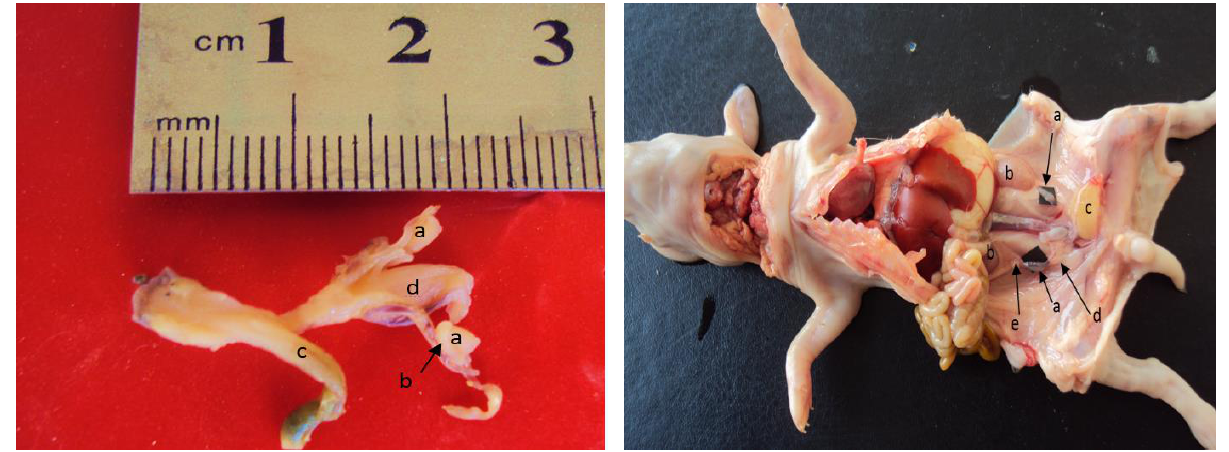
Figure, 1: Urogenital system of the Kit rabbit at 1- day age, shows the shape of the testes and epididymis a-testis b- epididymis c- rectum d- urinary bladder.